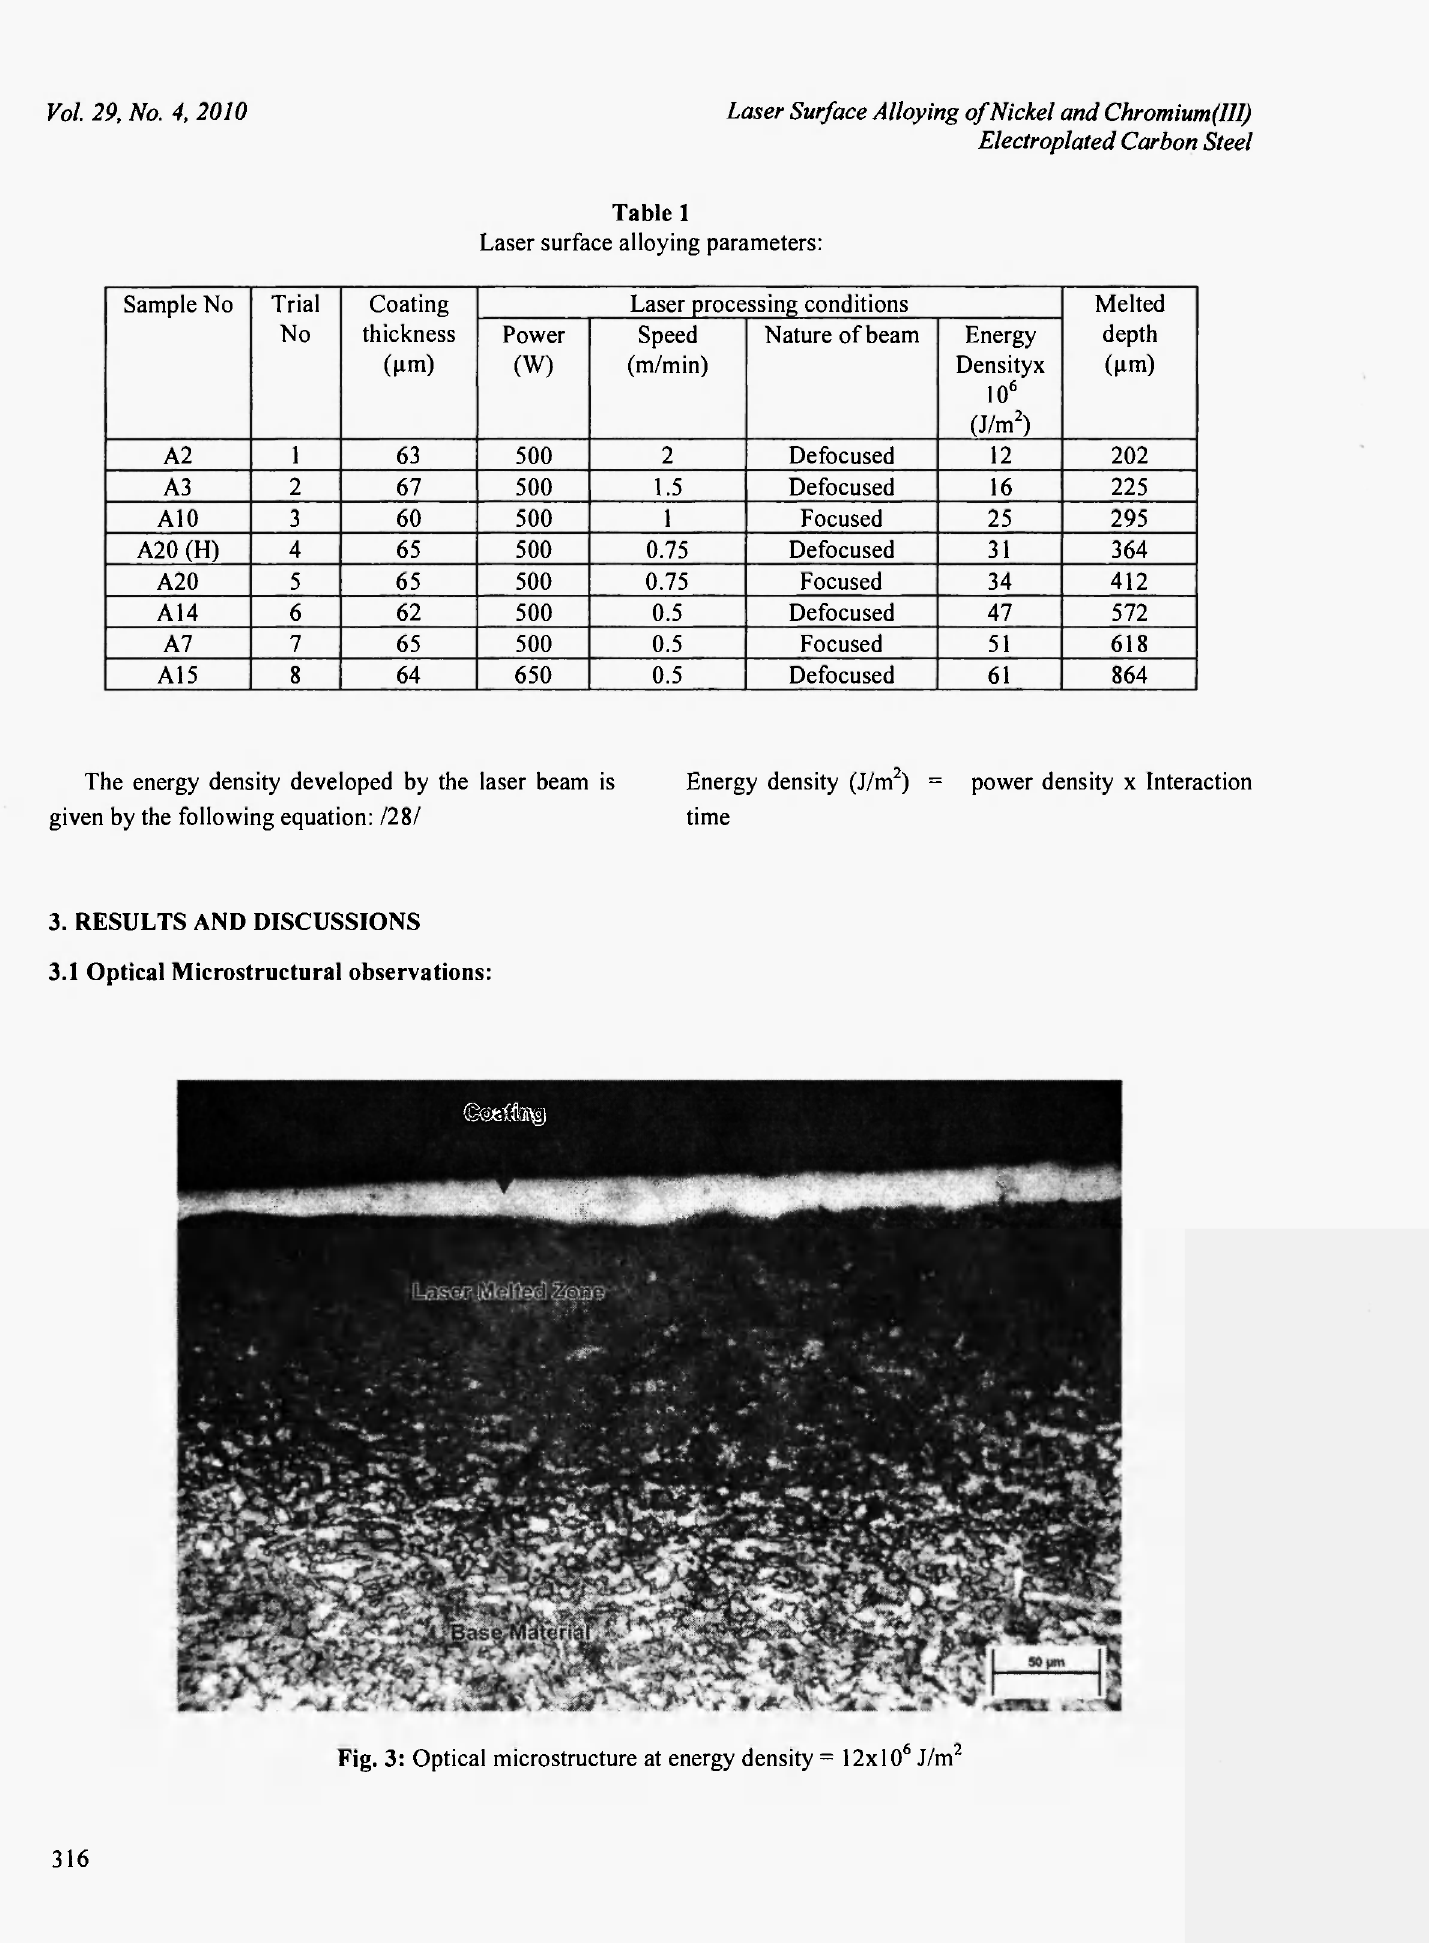
Laser surface alloying parameters: